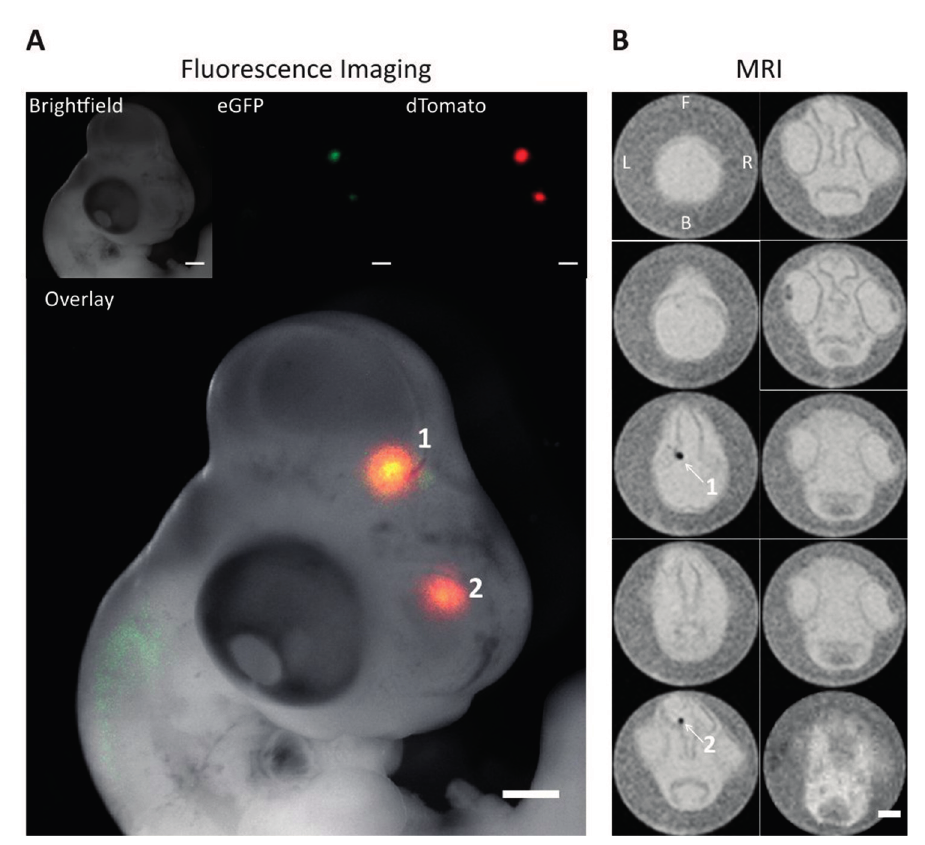
Figure 7. Fluorescence and magnetic resonance (MR) imaging of a chick embryo that received a bolus injection of cells overexpressing TfR1 and Fth1 . Cells (2 × 10 5 ) were implanted in the midbrain of chick embryos at E3. On E5 chicks were harvested from their eggs, imaged with a fluorescence stereomicroscope and then fixed prior to MR imaging. ( A ) Fluorescence images of the chick embryo and overlay with a brightfield image; ( B ) MR images of transverse sections along the rostrocaudal axis of the embryo; 10 sections are displayed in two columns displaying the head of the embryo. Scale bars correspond to 1 mm. Numbers indicate cell clusters and corresponding T 2 shortening effect. Position of the embryo: F-front, B-back, L-left,